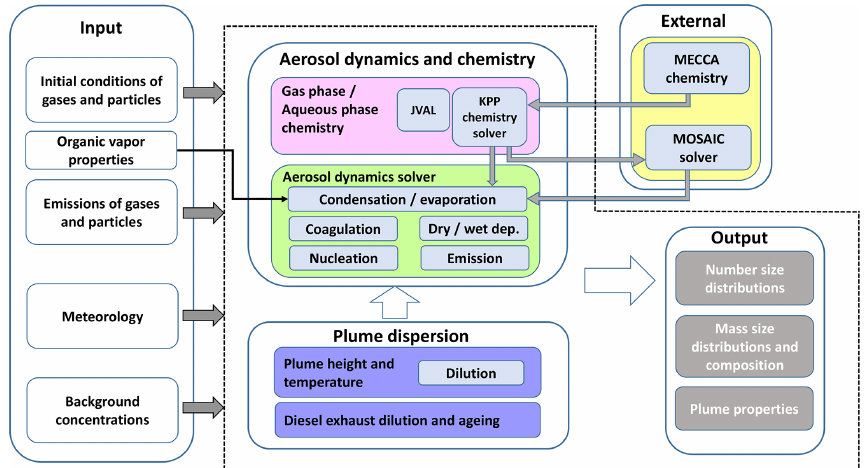
Figure 1. Illustration of the model structure. Input data are on the left side. The area with a dashed outline contains the MAFOR model. External modules: interface to MECCA v4.0 and interface to MOSAIC solver (the models are not part of MAFOR). MECCA v4.0 is used to create the modules for the KPP chemistry solver, and the JVAL solver provides photolysis rate